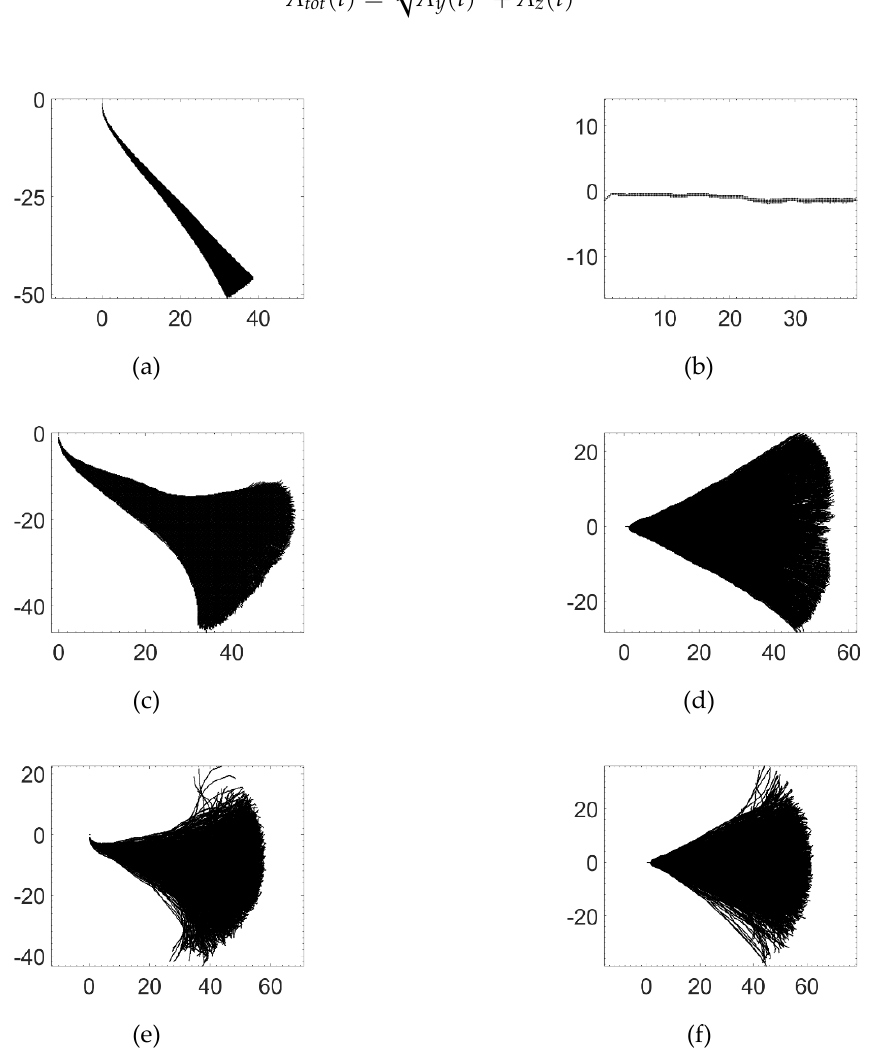
Figure 5. Representative envelopes of motion for Filament 1 in the vertical plane (left) and horizontal plane (right) at three Reynolds numbers (top, middle and bottom). ( a ) Vertical plane, 𝑅𝑒 = 202 ; ( b ) Horizontal plane, 𝑅𝑒 = 202 ; ( c ) Vertical plane, 𝑅𝑒 = 410 ; ( d ) Horizontal plane, 𝑅𝑒 = 410 ; ( e ) Vertical plane, 𝑅𝑒 = 804 ; ( f ) Horizontal plane, 𝑅𝑒 = 804 (x-axis and y-axis scales are in mm).